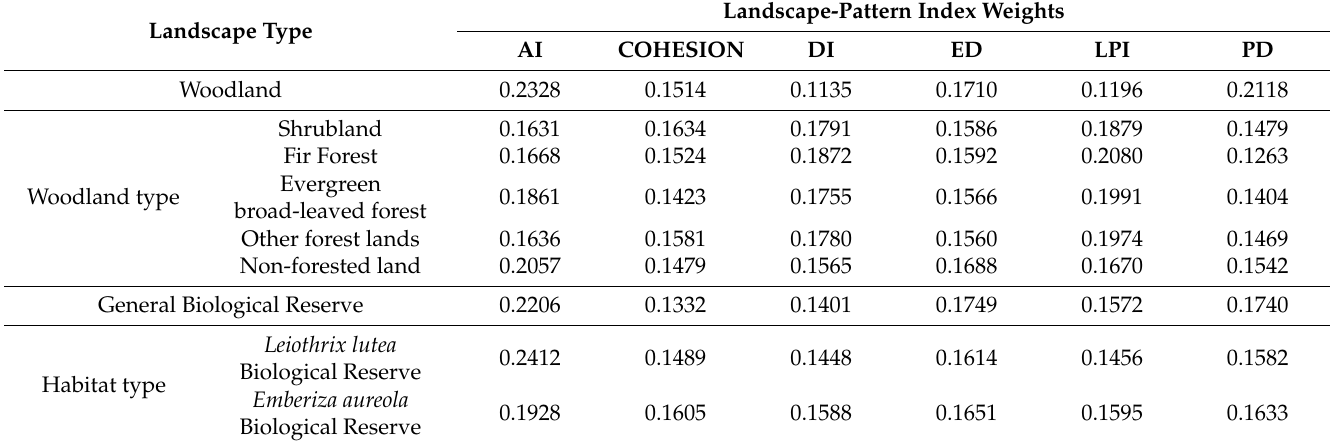
Table 4. List of landscape-pattern-index